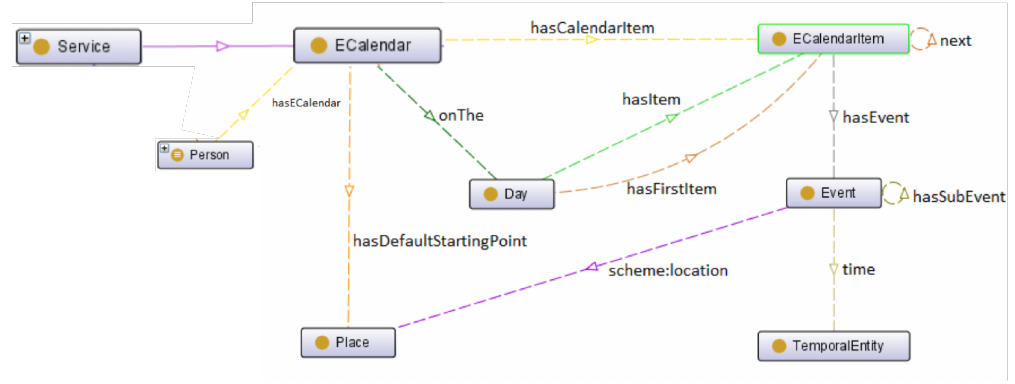
Figure 4. E-calendar